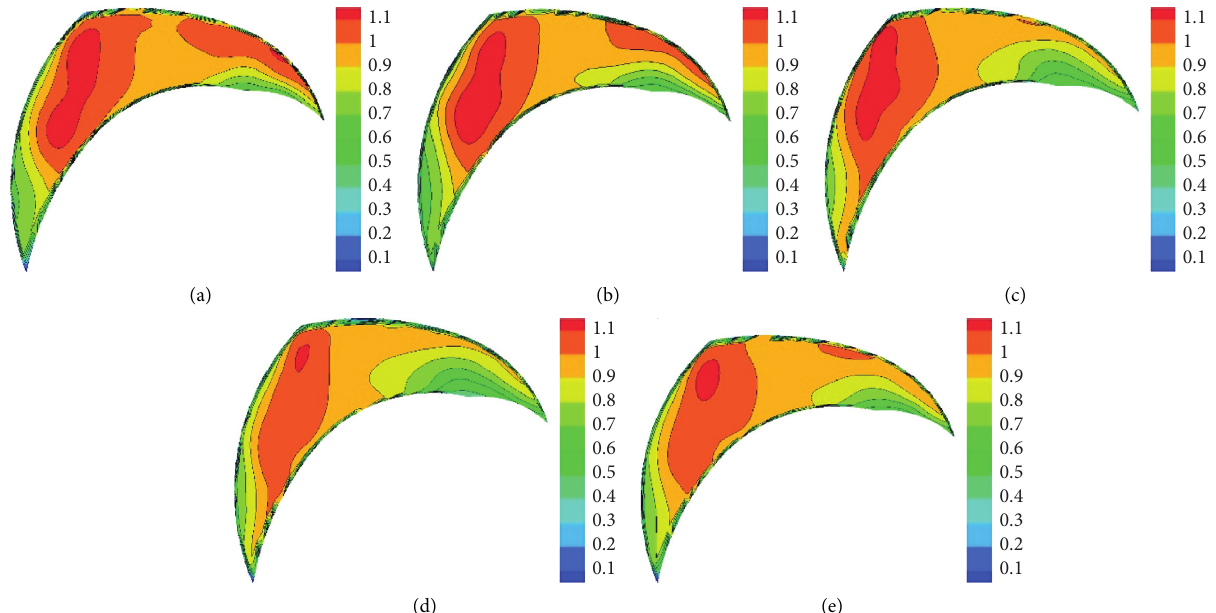
Figure 8: Distribution of slip factor in flow channel: (a) 600r/min 0.2 Q 0.2 Q BEP , and (e) 1400r/min 0.2 Q BEP .